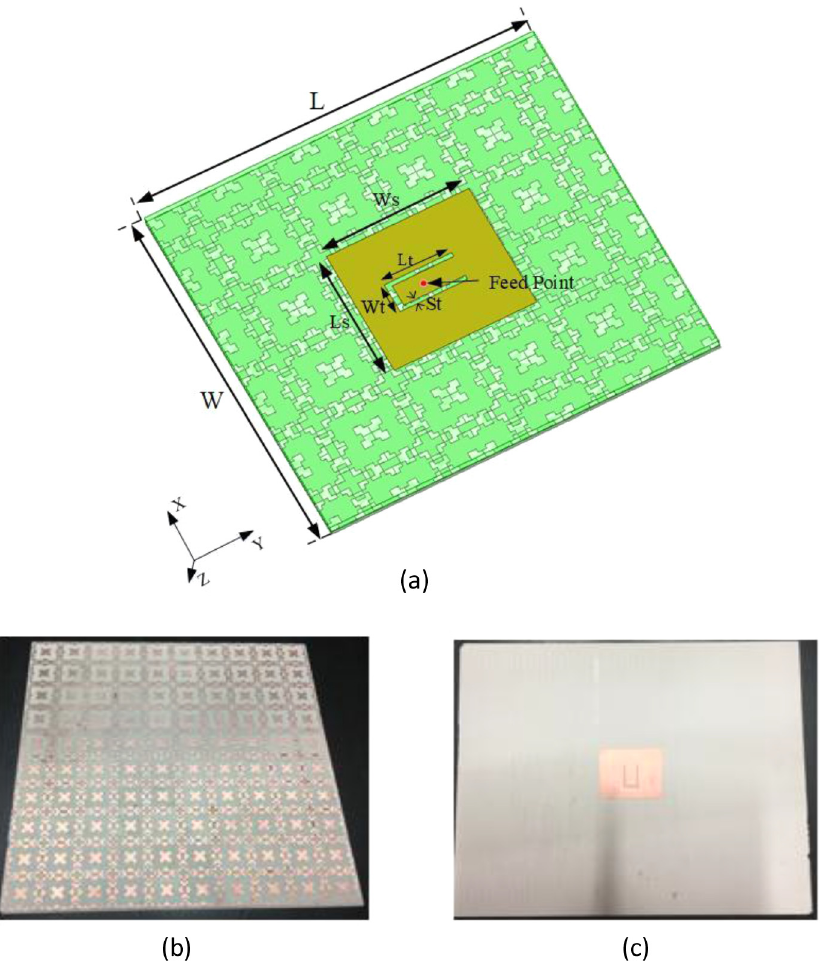
Fig. 4. (a) 3D view of the U-slot patch antenna based on the equivalent metaferrite substrate. The photograph of (b) the matesurface on the bottom of the Rogers TMM6 substrate, (c) U-slot patch antenna on the